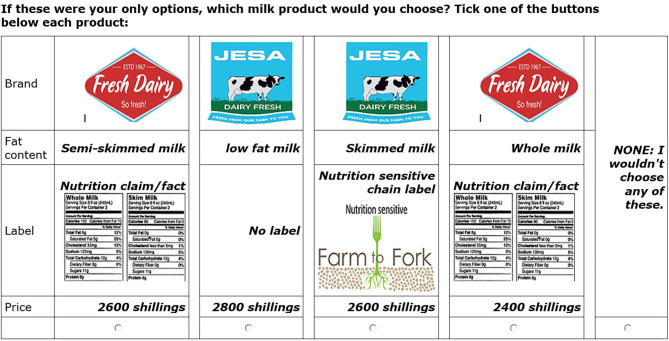
An illustration of a choice set used in the conjoint experiment.